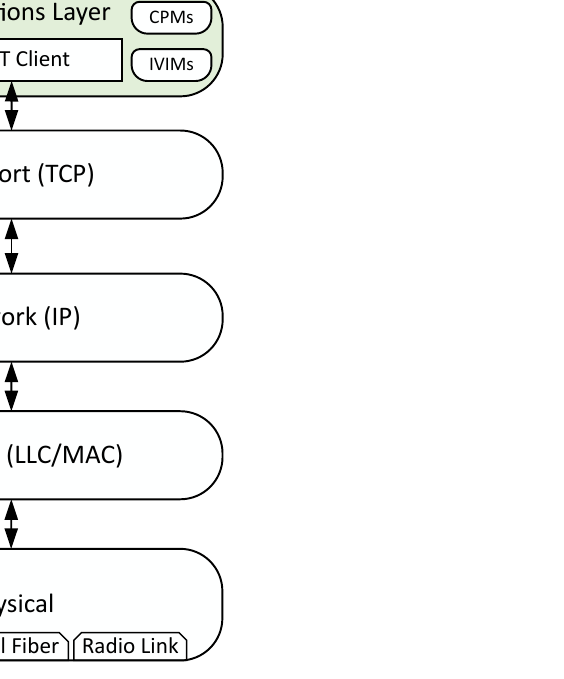
Figure 4. Protocol stack for MQTT message exchange over cellular (LTE/5G) and other